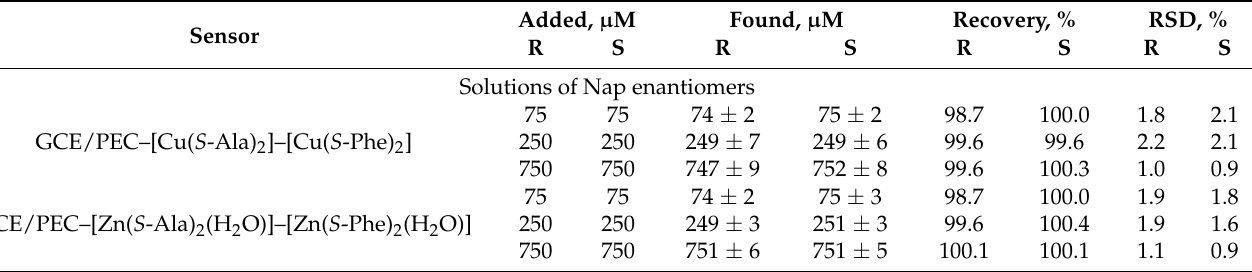
Table 4. DPV determination of R- and S-Nap (phosphate buffer solution with pH 6.86) and R- and S-Prp (0.05 M sulfuric acid) in model solutions on GCE modified by PEC composites [M( S